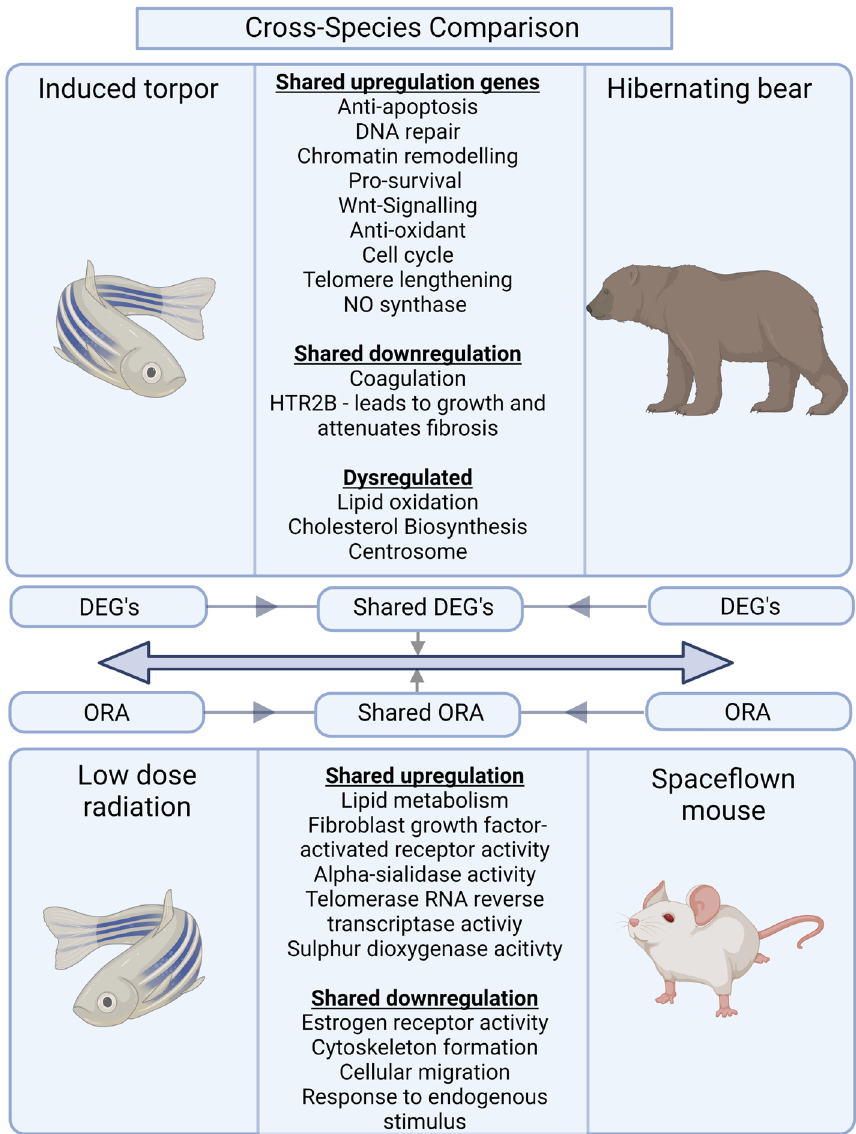
Figure 6. Comparison of our zebrafish radiation group vs space flown mouse and the zebrafish induced torpor group vs hibernating bear. The results between the zebrafish radiation model and the space flown mouse show shared upregulation of genes involved in sulphur dioxygenase activity, telomerase RNA reverse transcriptase, alpha-sialidase activity, and fibroblast growth factor receptor activity. Shared downregulated genes included the estrogen receptor ( ESR1 ), and genes involved in cytoskeleton formation and cellular migration. Additionally, shared biological processes included lipid metabolism and response to endogenous stimuli. Comparison of the torpor group versus the hibernating bear showed shared upregulation of anti-apoptotic genes, DNA repair genes, pro-survival genes, antioxidant genes, and Wnt signaling. Shared downregulated genes included anticoagulant genes, while dysregulated genes were involved in lipid oxidation and cholesterol synthesis. Furthermore, shared BP included a response to ROS, cell cycle checkpoints, telomere lengthening, and nitric oxide synthase. Created with